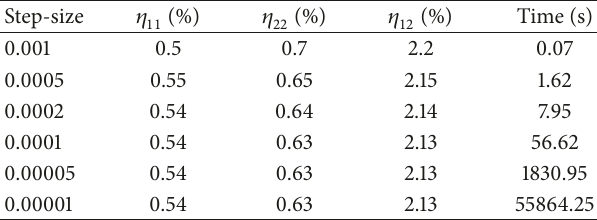
Table 3: Loss factor of fiber-reinforced composite obtained by different step-size parameters and its time